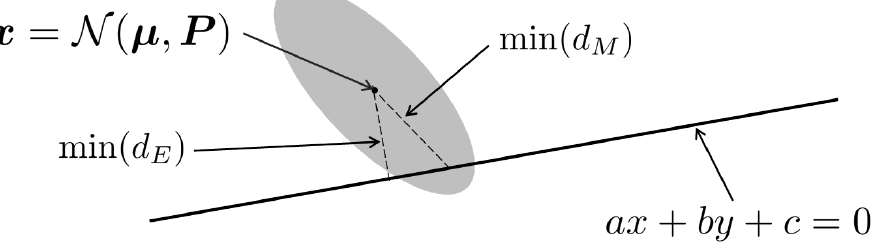
Figure 1. An illustrative figure showing an image feature pixel x represented as a two-dimensional random variable with mean µ and covariance matrix P ; the epipolar line is represented as a straight line with equation ax + by + c = 0, min ( d M ) is the minimum Mahalanobis distance, while min ( d E ) is the minimum Euclidean distance. In standard 8-point algorithms, the (inverse) Euclidean distance is used as the weight, while our method utilises the Mahalanobis distance which is statistically more consistent (shorter distance to the line in this